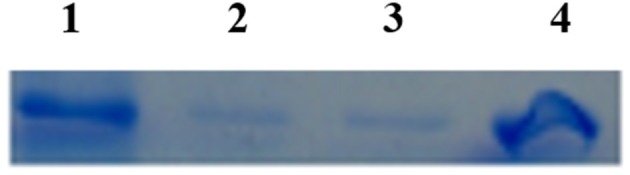
Analysis of the soluble recombinant rCramoll produced by E. coli at the optimal culture conditions (Cell density of 0.5; IPTG at 0.1 mM; induction at 15°C and for 21 h. 1-Total production of rCramoll in E. coli; 2-rCramoll in E. coli soluble fraction; 3-rCramoll in E. coli insoluble fraction; 4-Previously purified rCramoll (5 μM) used as a standard for the quantification.